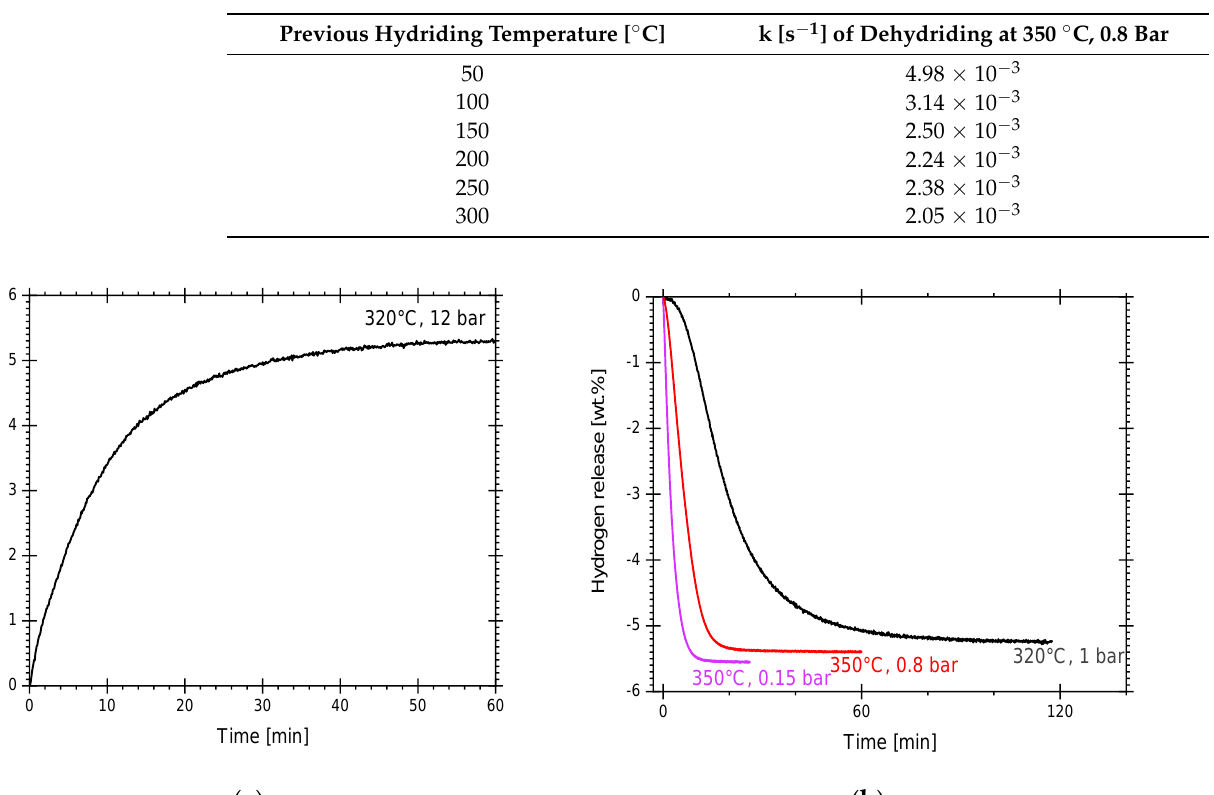
Table 2. The rate constants for the dehydriding reaction of cryogenically prepared Mg-15wt.% VCl 3 at 350 ◦ C and 0.8 bar absolute pressure. Previous Hydriding Temperature [ ◦ C]